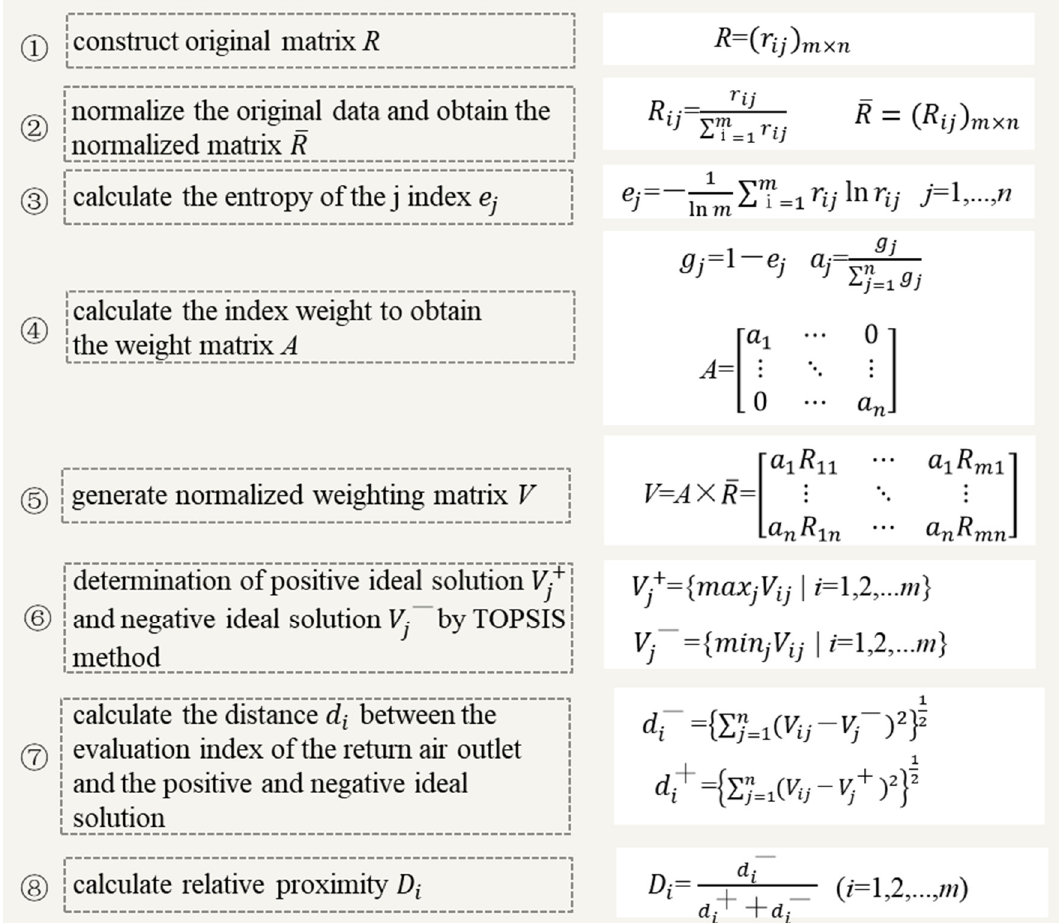
Figure 6. TOPSIS calculation process in this study.